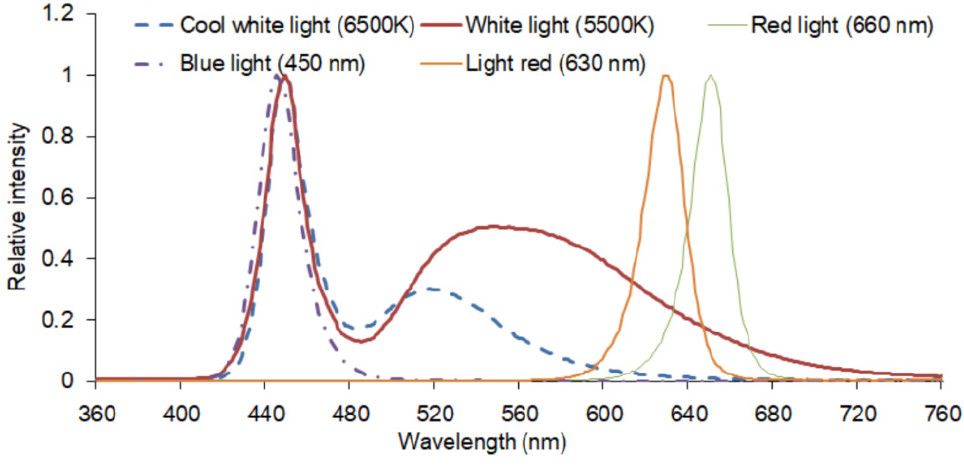
Figure 2. Five LED spectrums.